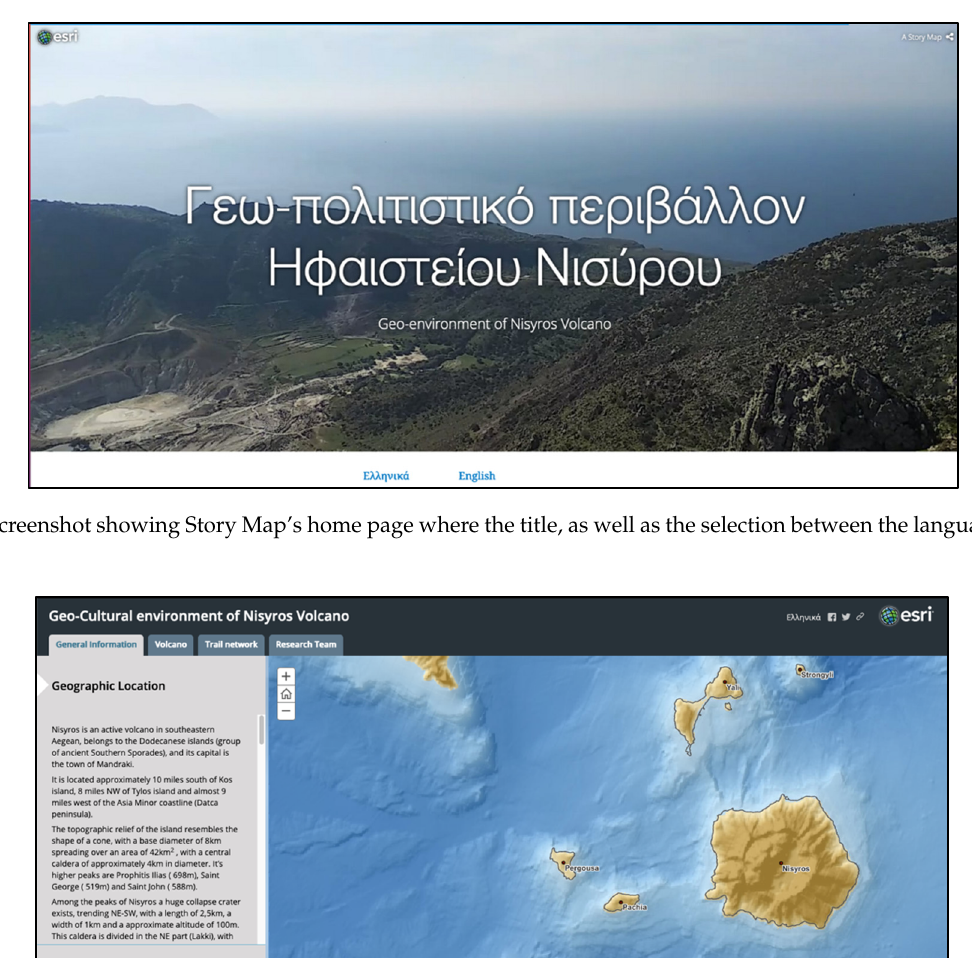
Figure 5. Screenshot showing Story Map’s home page where the title, as well as the selection between the languages, appear.